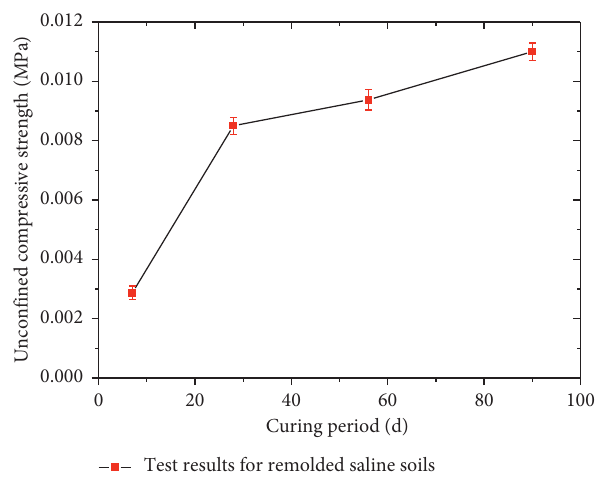
Figure 4: Variation in UCS of remoulded saline soils during curing period.